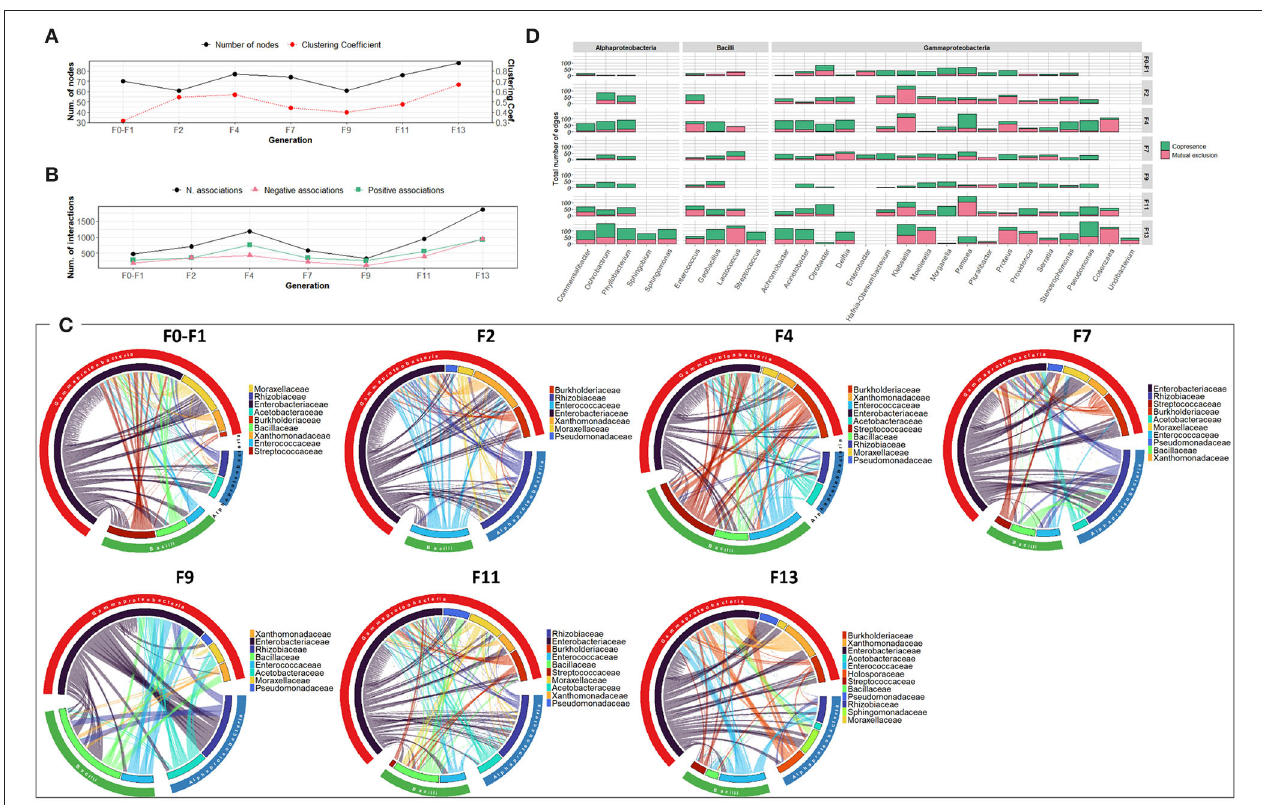
FIGURE 4 | Bacterial community network within the guts of C. capitata adult during laboratory adaptation of Vienna 8 FD-GSS strain. (A) Total number of nodes and clustering coefficient, (B) Total number of negative (red) and positive (green) associations, (C) Chord diagram displaying direct relationship between OTUs at family level. The size of the ribbon is proportional to the weight of the association between the OTUs assigned to the respective segments and the color of the ribbon present in the direction of the interaction. (D) Number of positive and negative associations at the genus